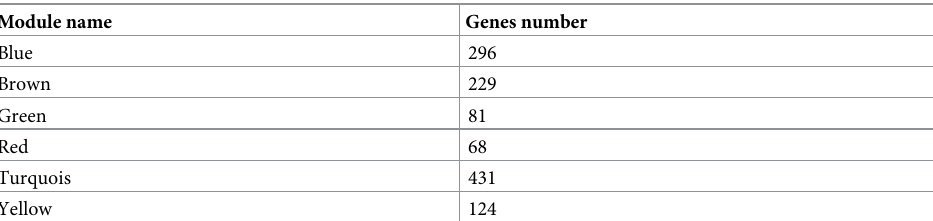
Table 2. Modules of biotic stress